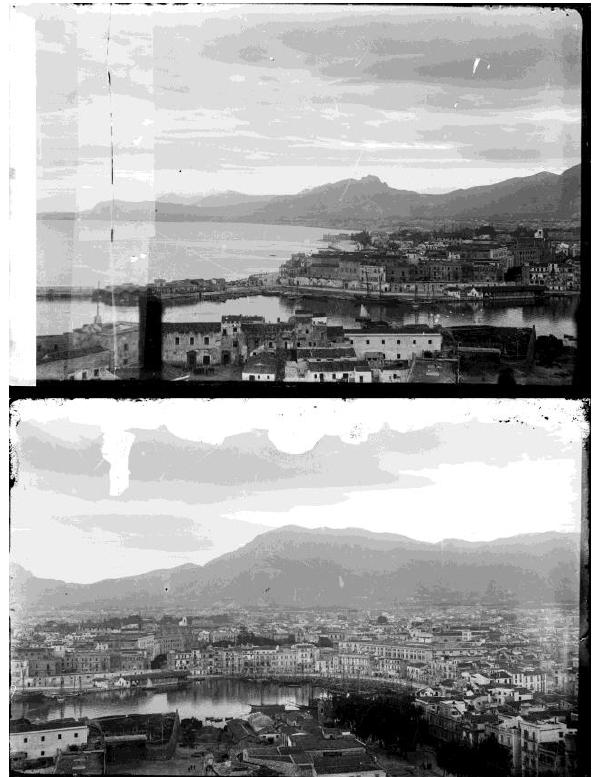
Figure 1: The southern front of the ‘Cala’ in 1924 and today.